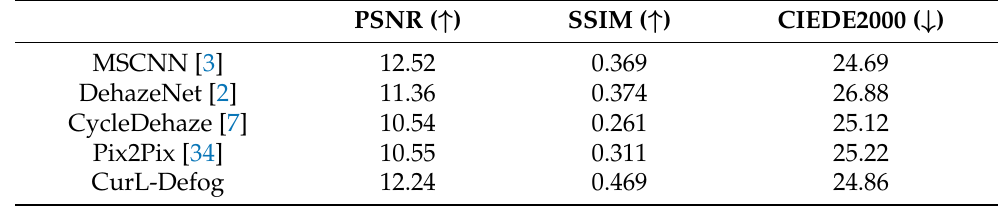
Table 6. Average SSIM, PSNR, and CIEDE2000 scores of the dehazing on the Dense-Haze